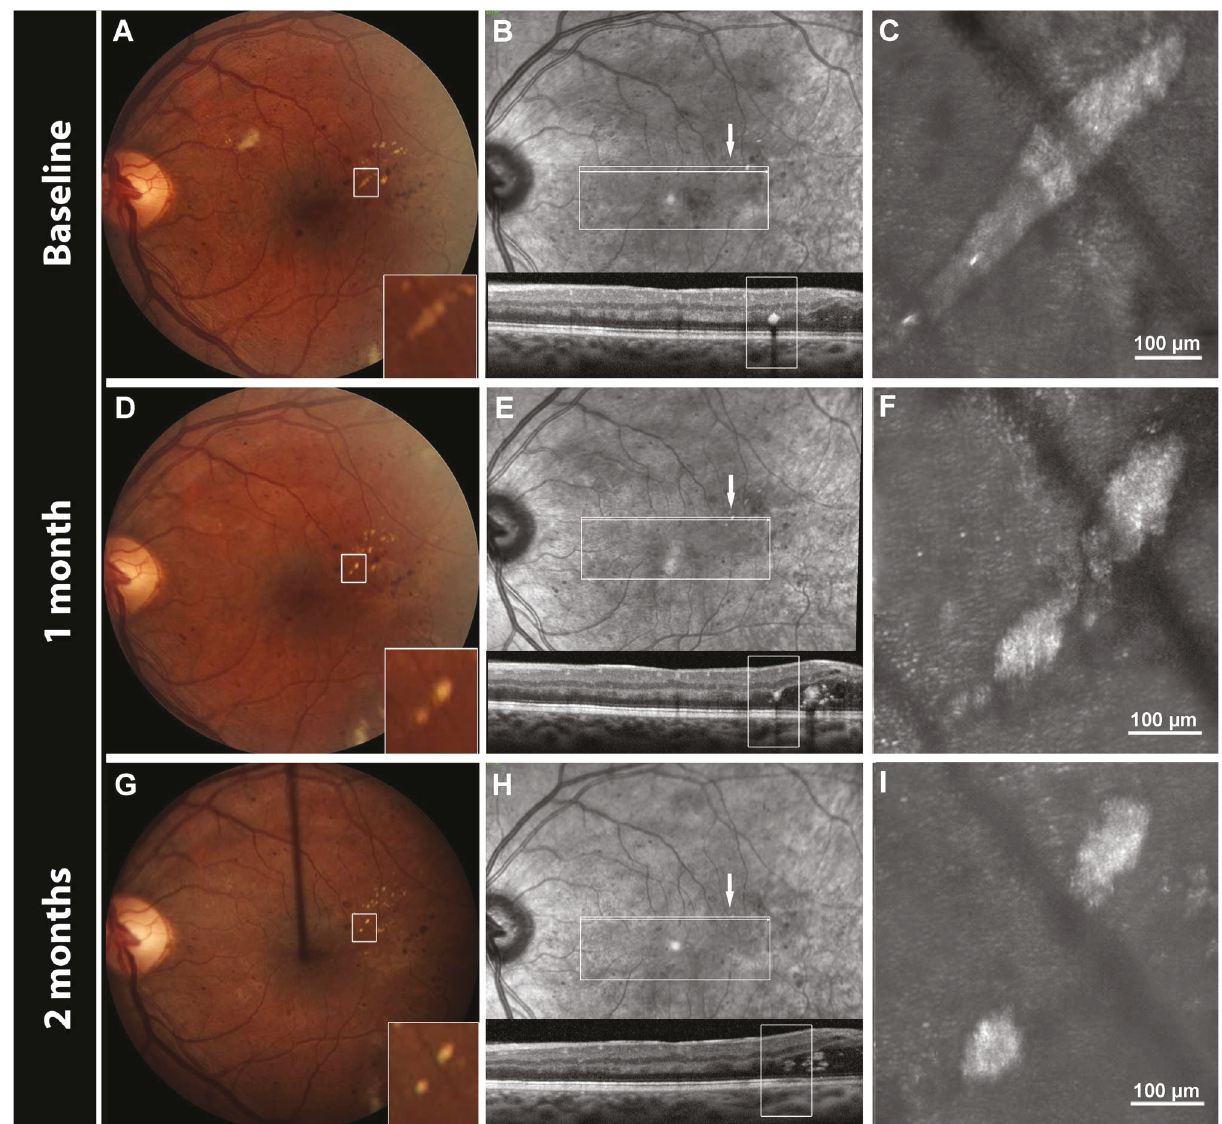
Figure 5: Multimodal imaging of a resolving hard exudate (HE) over a 2-month period. Intravitreal ranibizumab injections for center- involved diabetic macular edema were performed at the baseline and 1-month visits. The HE is clearly visible on color fundus photography (A, D, G) and IR images (B, E, H). Its location within the outer nuclear layer can be determined in cross-sectional SDOCT B-scans (B, E, H). Confocal AOSLO images (C, F, I) of the